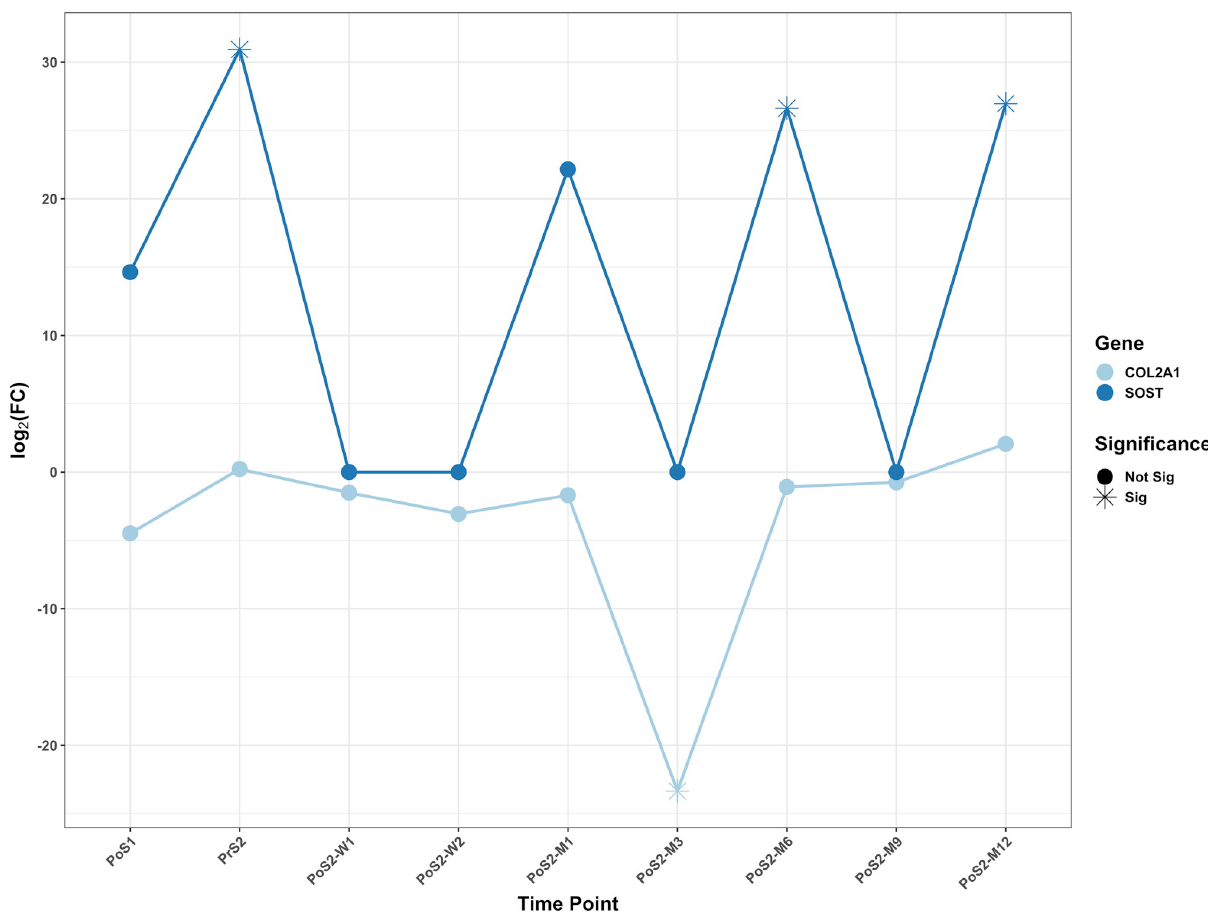
Fig 4. A scattergram showing the significantly differentially expressed genes annotated to bone remodeling-related GO processes. Two genes, SOST and COL2A1, were identified. The SOST exhibited more of the cyclic nature of up-regulation, while COL2A1 was significant at a single time point, at three months, post-surgery